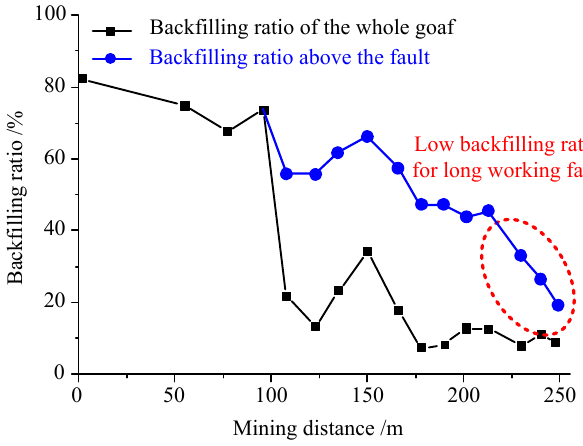
Figure 3. Variations in the gangue backfilling ratio in the 845 working face.